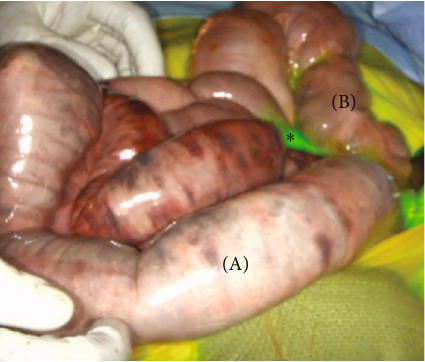
Figure 3: Perfusion to edge of small bowel mesentery but not beyond ( ∗ ); the small bowel serosa has no perfusion.